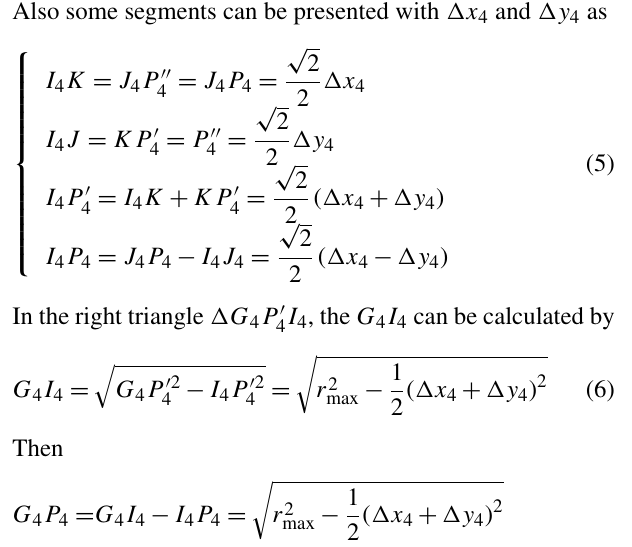
Figure 7. Equivalent transformation progress of reachable area of leg 4. First, translating to the quadrant of pink dash line centering on P (cid:48)(cid:48) , then to the quadrant of blue dash line centering on P (cid:48) 4 I 4 is the intersection point of the blue dash line and the short red line; K 4 is the intersection point of the blue dash line and the pink dash